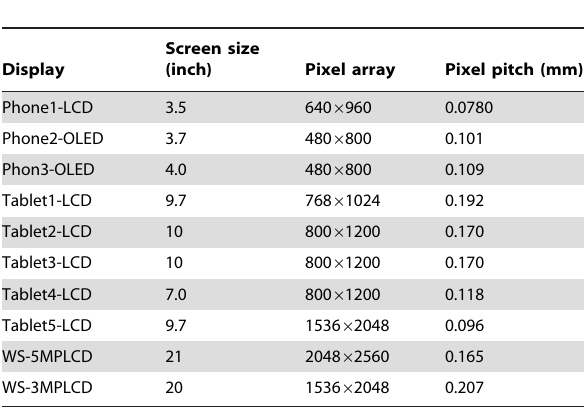
Table 1. Specifications for the display devices tested in this